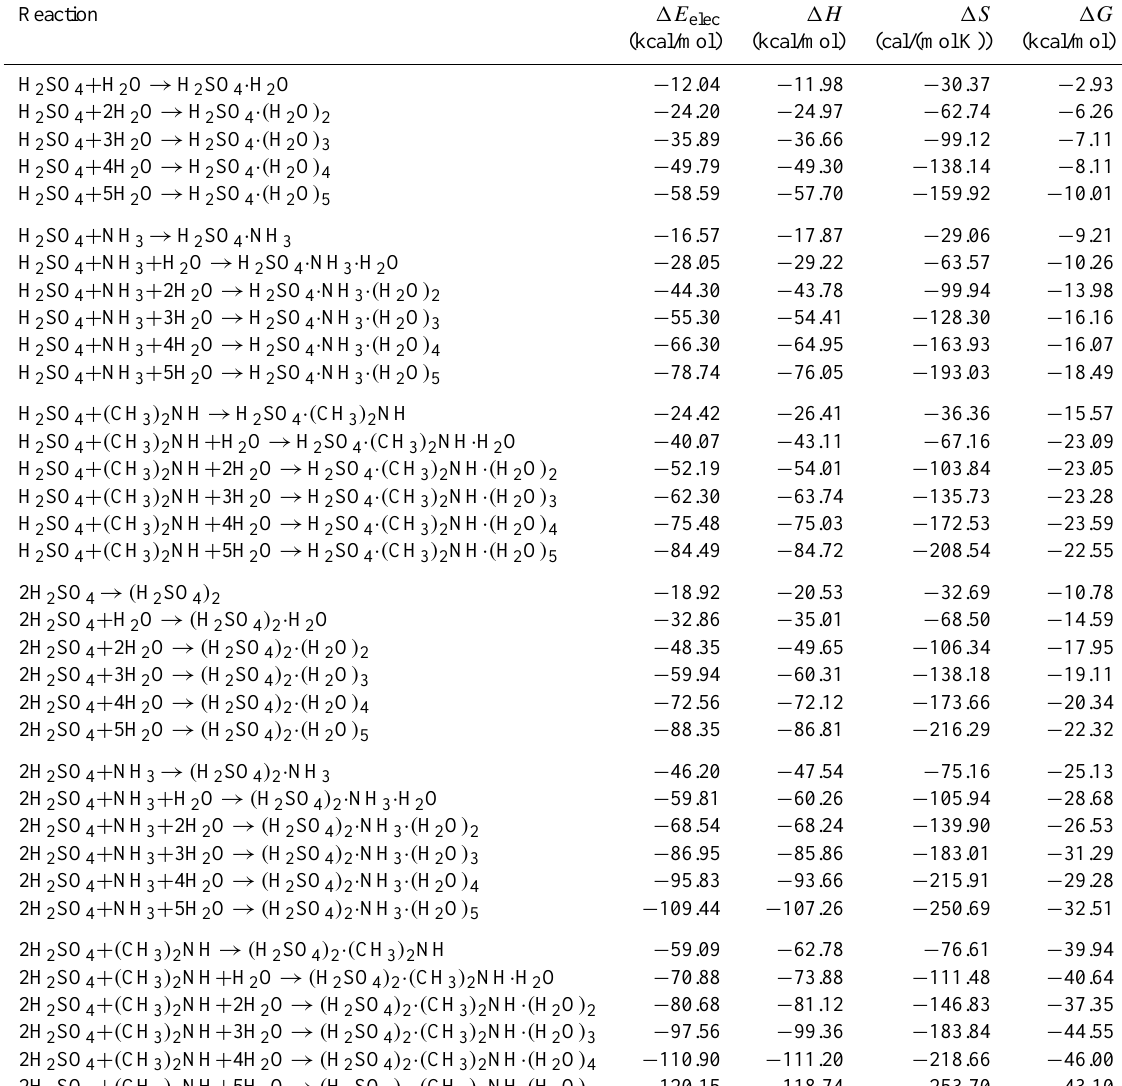
Table 2. The electronic binding energies 1E elec (at the RI-MP2/aug-cc-pV(T + d)Z level of theory) and the thermochemical parameters enthalpy 1 H , entropy 1S and the Gibbs free energy 1G (at T = 298 . 15K and P = 1atm) for the formation of molecular clusters under study.